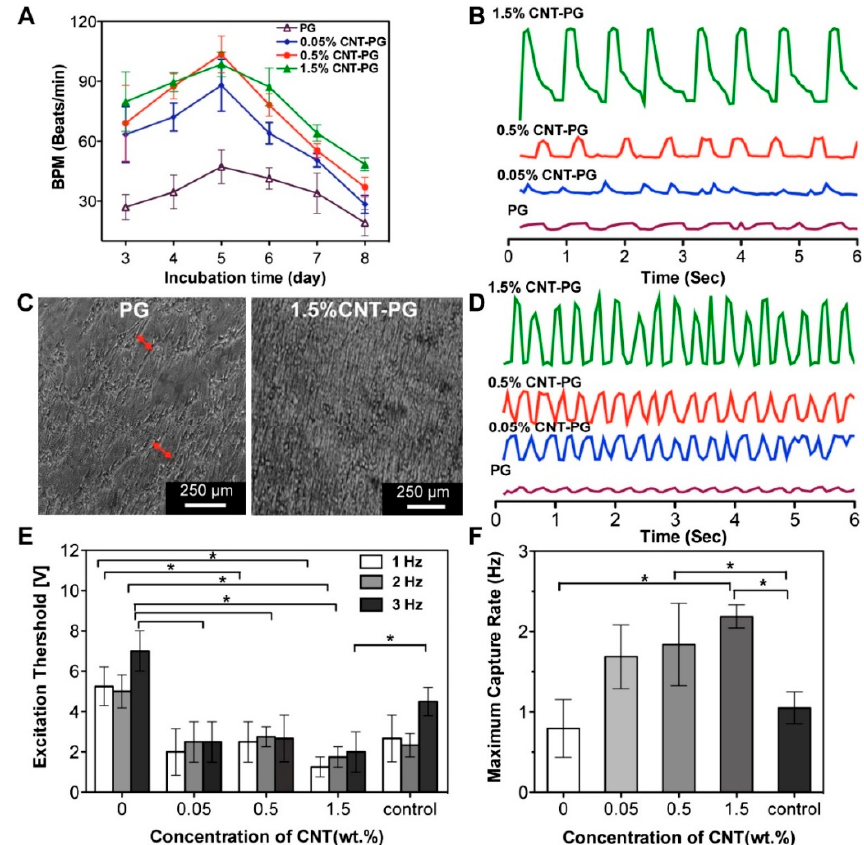
Figure 16. Electrophysiological functions of engineered cardiac constructs. ( A ) Beating frequency (BPM) of constructs as a function of CNT concentration and incubation time. ( B ) Representative spontaneous contraction patterns of CMs cultured on poly(glycerol sebacate):gelatin (PG) scaffolds and CNT incorporated scaffolds recorded after seven days of cultivation. ( C ) Phase-contrast images indicating organized tissue construct and non-continuous aligned tissue (red arrows) on the CNT–PG and PG scaffolds, respectively after seven days of culture. ( D ) Representative contraction patterns of electrically stimulated CMs on PG scaffold compared to CNT–PG scaffold after seven days of culture (frequency = 1). ( E ) Excitation threshold and ( F ) maximum capture rate of CMs seeded on scaffolds, indicating that increasing the CNT concentration and aligned structures significantly reduced excitation threshold and enhanced maximum capture rate (CMs cultured on random 1.5% CNT–PG scaffold was considered as control). (*P < 0.05 by one-way ANOVA analysis followed by Tukey's post-hoc test). [188]. Reproduced with permission from Kharaziha et al., Biomaterials , published by Elsevier, 2014.